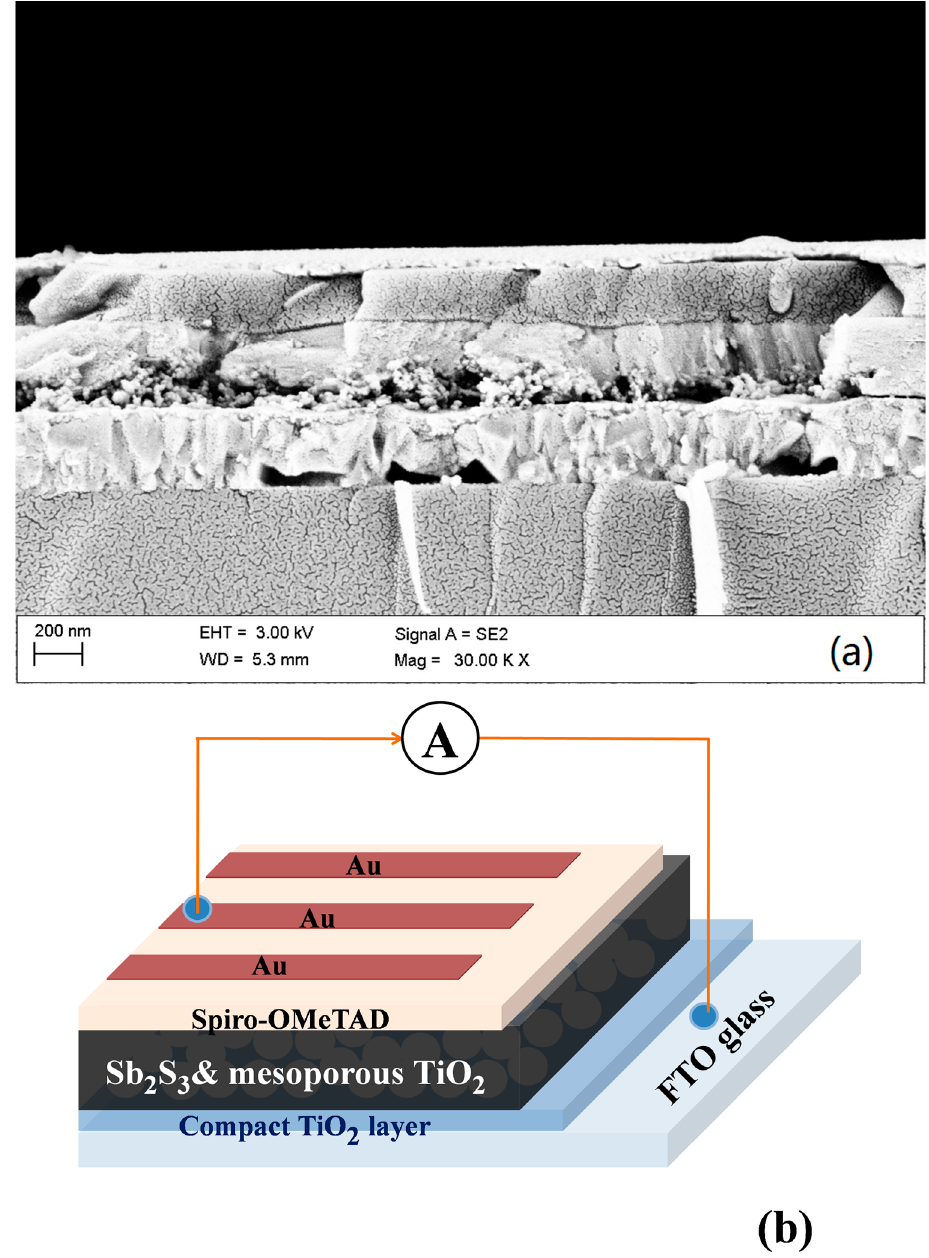
Figure 4. ( a ) Cross-section SEM of the Sb 2 S 3 solar cells and ( b ) the configuration of the device.